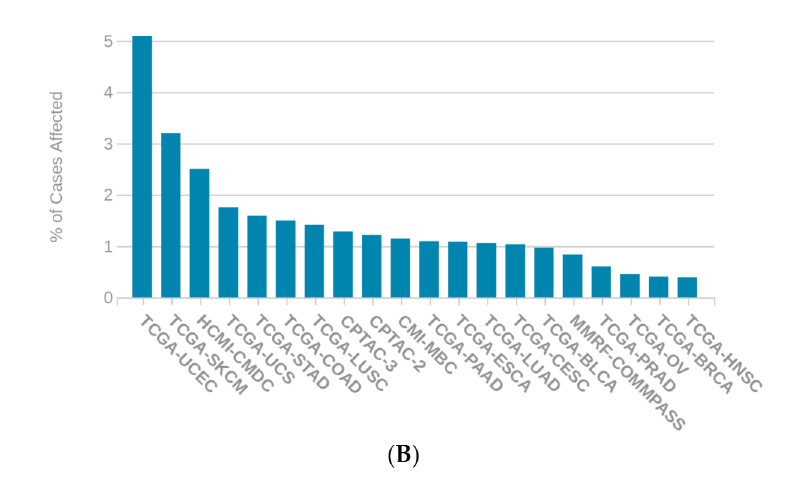
Figure A2. CNV and mutation distribution of PD1 (SPATA2) in different cancer types. ( A ) CNV distribution. ( B ) Mutation distribution.